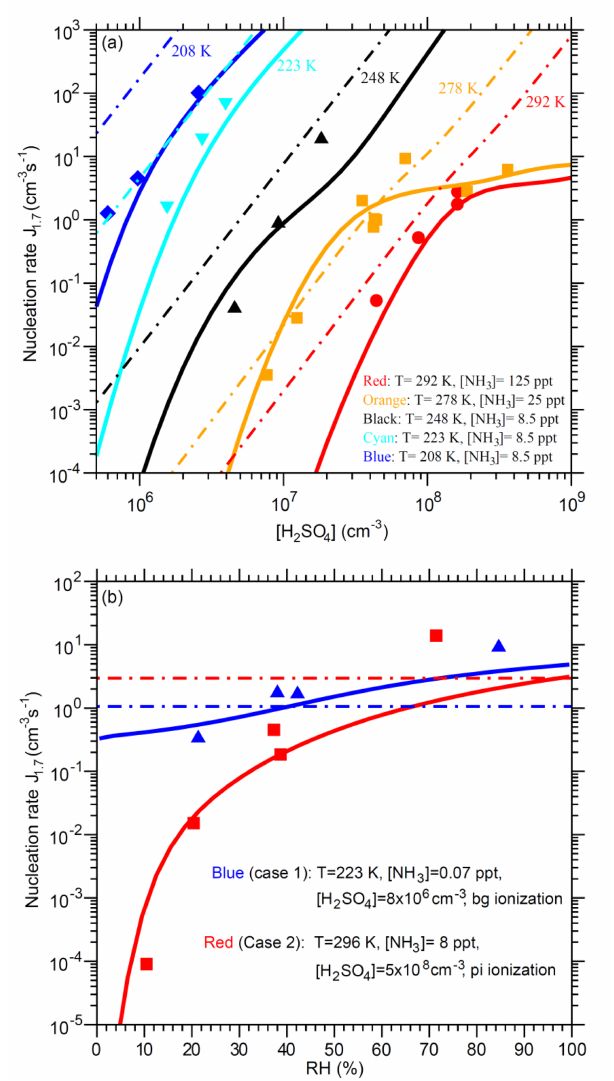
Figure 7. Comparison of TIMN simulations (solid lines), CLOUD- para predictions (Dunne et al., 2016) (dot-dashed lines), and CLOUD measurements (symbols and data from Dunne et al., 2016) of the dependences of nucleation rates on (a) [H 2 SO 4 ] at five differ- ent temperatures ( T = 292, 278, 248, 223, and 208K) and (b) RH at two sets of conditions as specified. [NH 3 ] is in parts per trillion, by volume. Error bars for the uncertainties in measured [H 2 SO 4 ] ( − 50%, + 100%), [NH 3 ] ( − 50%, + 100%), and J 1 . 7 (overall a factor of 2) are not shown. To be comparable, the CLOUD data points given in Dunne et al. (2016) under the conditions ( T , RH, ionization rate) with [NH 3 ] or [H 2 SO 4 ] close to the corresponding values specified in the figure legends have been interpolated to the same [NH 3 ] (Fig. 7a) or [H 2 SO 4 ] (Fig. 7b) values.